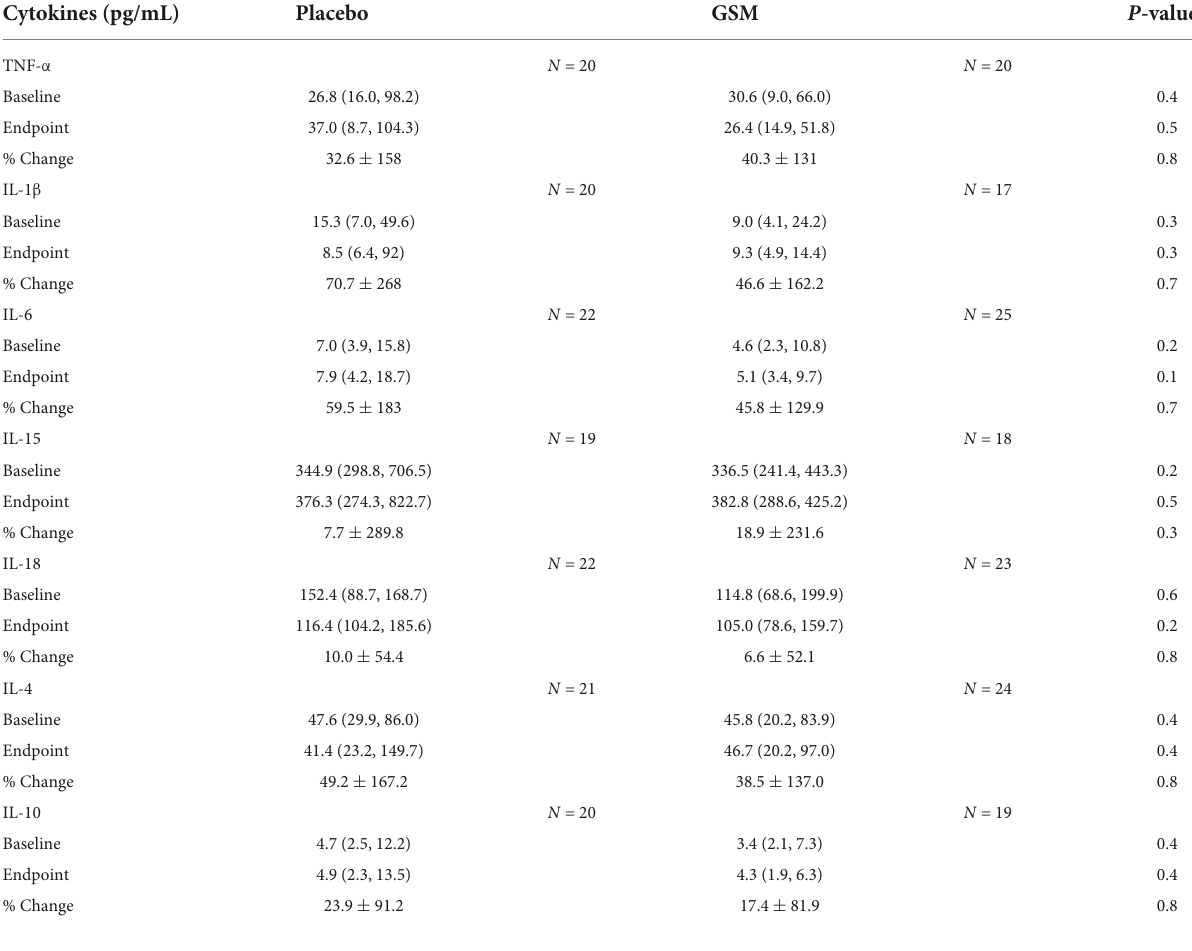
*NosignificantdifferencebetweenGSMvs.placeboatbaselineandendpointusingMann-Whitney U test.Nosignificantdifferencewasobservedovertime(baselinevs.endpoint)within thegroupusingpaired t